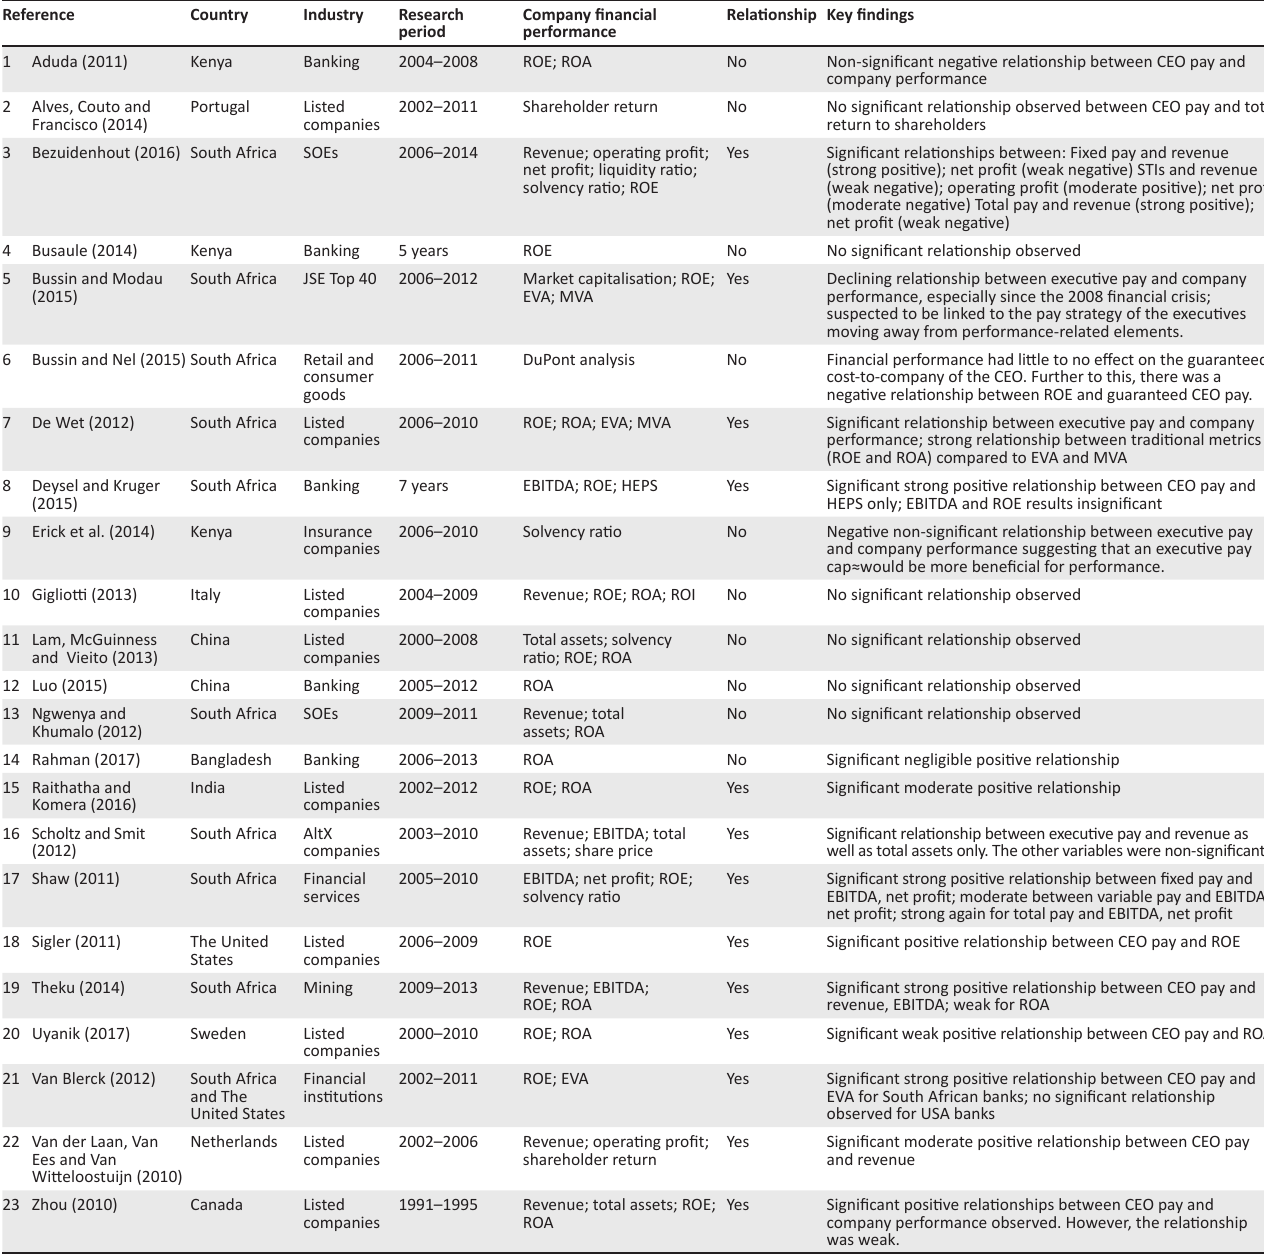
TABLE 1: Summary of existing literature highlighting the key findings and the relationship between executive pay and company financial performance. Reference Country